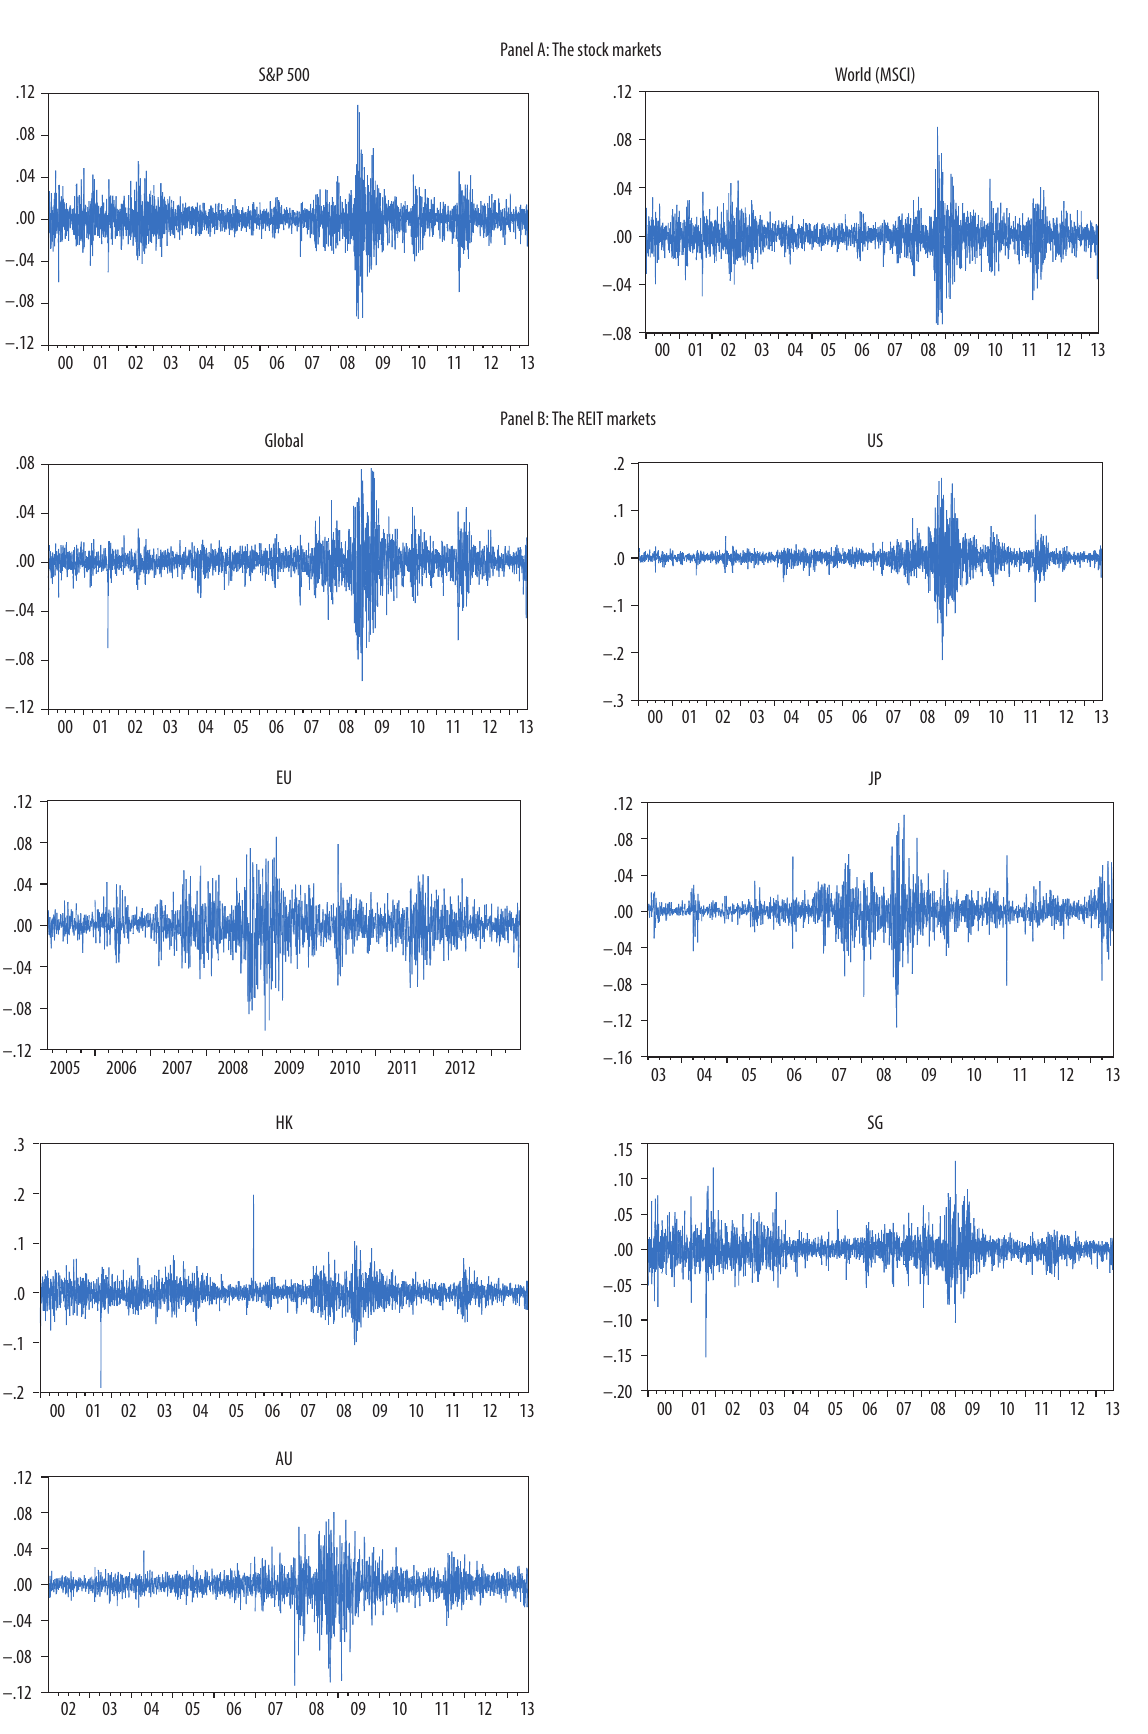
Fig. 1. Stock and REIT returns for each market over the sample